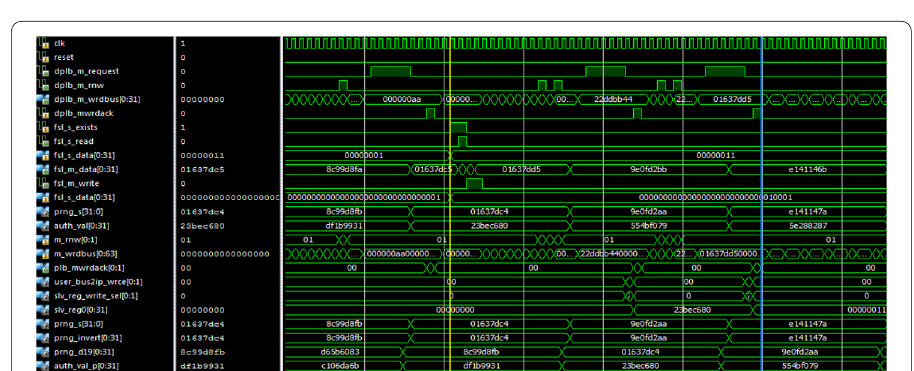
Fig. 6 Sequence of signals for an encryption transfer between Microblaze and crypto